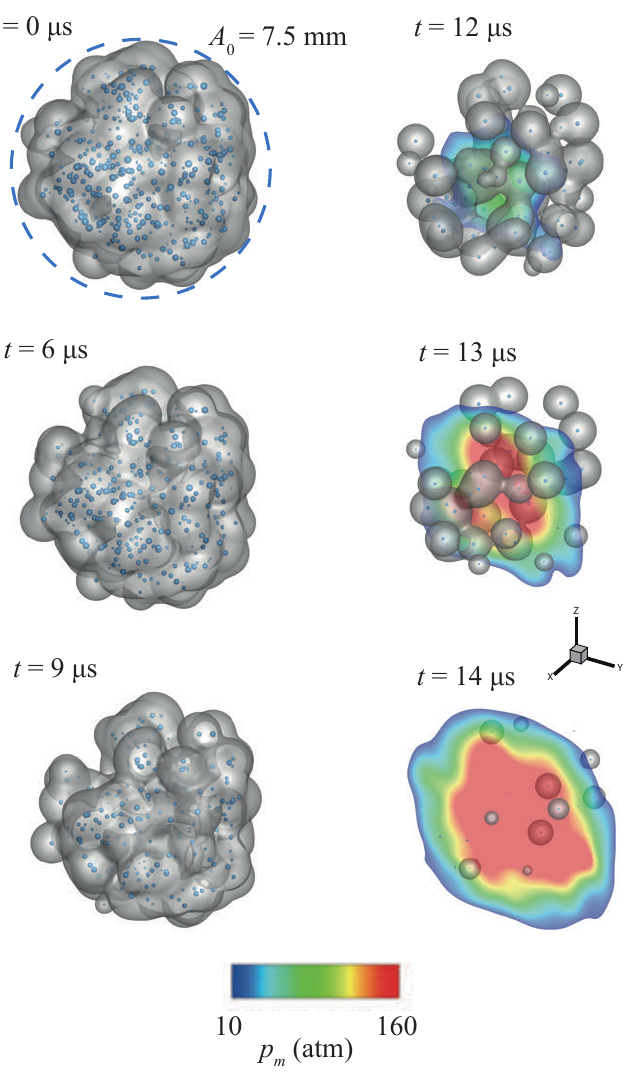
Figure 17. The snapshots of the vapor bubble cloud collapse process initially with N 0 = 400 vapor bubbles ( t = 0 µ s, 6 µ s, 9 µ s, 12 µ s, 13 µ s, and 14 µ s). Distribution of the vapor bubbles is visualized both by the iso-surface of the volume fraction α g = 0.002 ( α l = 0.998) and the radius R b of Lagrangian spherical particles. Slices of the high pressure area (higher than 10 atm) at the center of the bubble cloud are also plotted, which indicate the cloud collapse induced violent pressures.